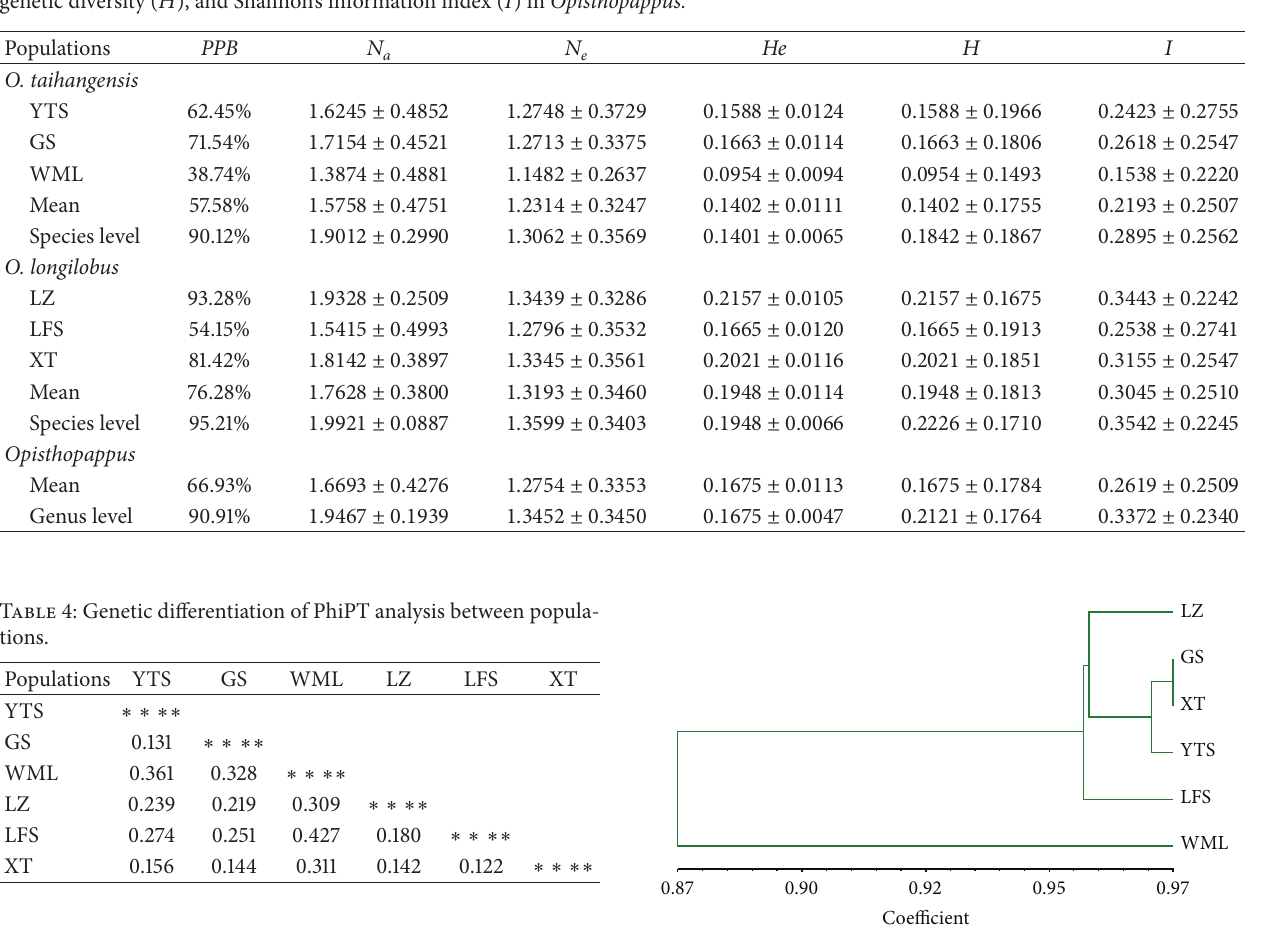
Table 3: Percentage of polymorphic loci ( PPB ), number of alleles ( 𝑁 𝑎 ), number of effective alleles ( 𝑁 𝑒 ), expected heterozygosity ( He ), Nei’s genetic diversity ( 𝐻 ), and Shannon’s information index ( 𝐼 ) in Opisthopappus.